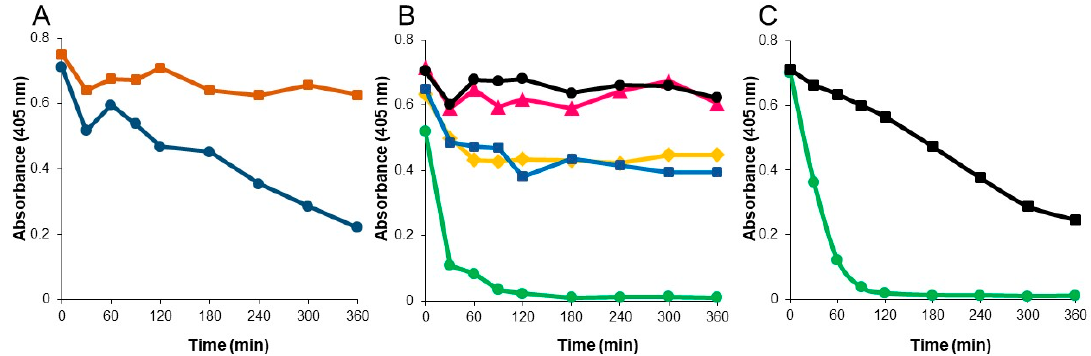
Figure 3. Functional stability of P2A incubated with human chyme under di ff ering conditions. ( A ) P2A incubated with mixed human chyme supplemented with 0.1 mM ZnSO 4 (orange squares) or without zinc (blue circles). ( B ) P2A incubated with human chyme samples collected from five di ff erent donors. Chyme 1: pink triangles, Chyme 2: black circles, Chyme 3: green circles, Chyme 4: yellow diamonds, Chyme 5: blue squares. ( C ). P2A incubated with Chyme 3, pH 5.6 (green circles) or pH-adjusted Chyme 3, pH 7.0 (black squares). Samples were collected over 6 h and assessed for beta-lactamase activity.